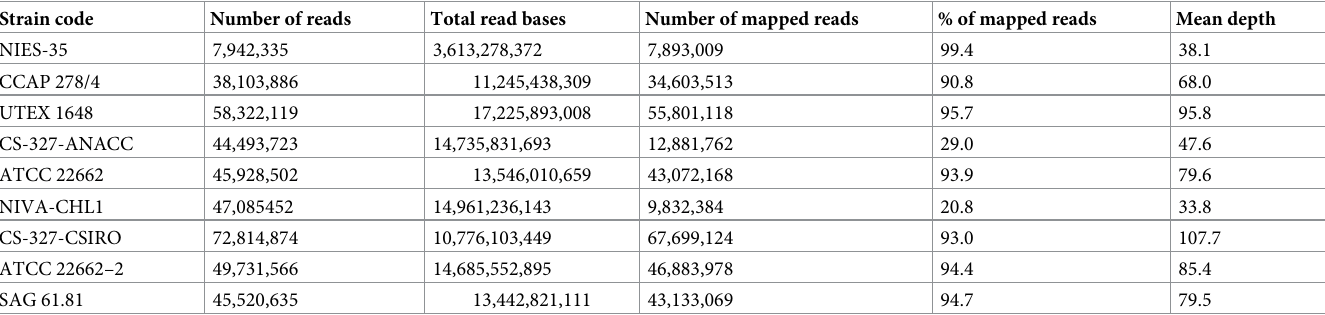
Table 2. Summary of genome sequencing using Illumina MiSeq. Strain